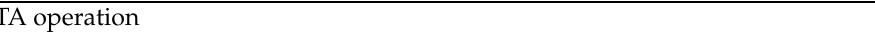
Algorithm 2 R-STA